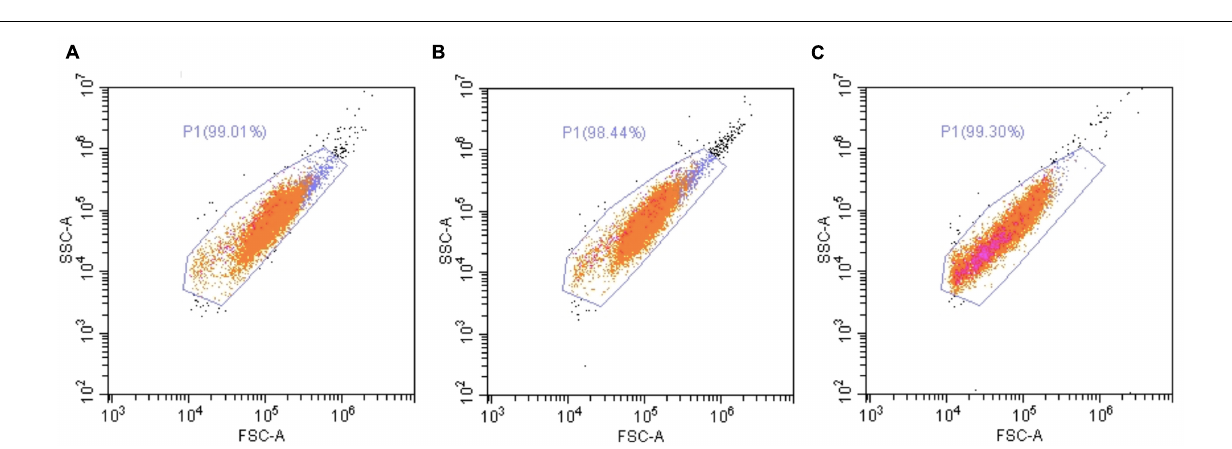
FIGURE 6 | Flow cytometry analysis of A. viridis cultivated cells under a 7-days treatment with H 2 O 2 . Flow cytometry analysis were performed on cultivated cell population by excitation at 488 nm and detection at 515–530 nm, after 7 days of incubation without H 2 O 2 (A) or with 200 µ M (B) or 500 µ M (C) of H 2 O 2 . Representative dot plots of all experiments performed are shown. Orange dots: cells of interest; pink dots: green-autofluorescent